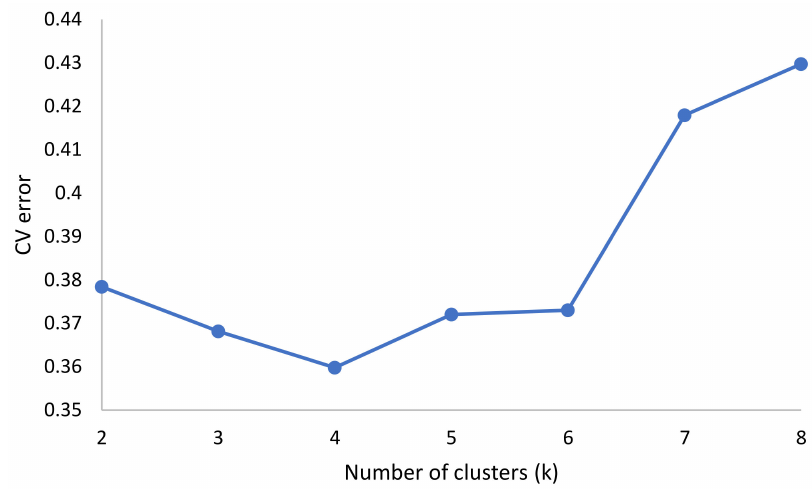
Figure 4. Variation of cross-validation (CV) error as a function of number of clusters.